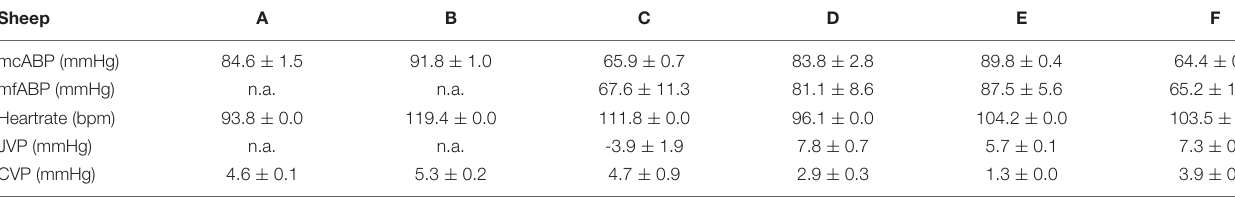
TABLE 2 | Mean hemodynamic pressures and heart rate measured during a 10-min baseline. Sheep A B C D E mcABP (mmHg)